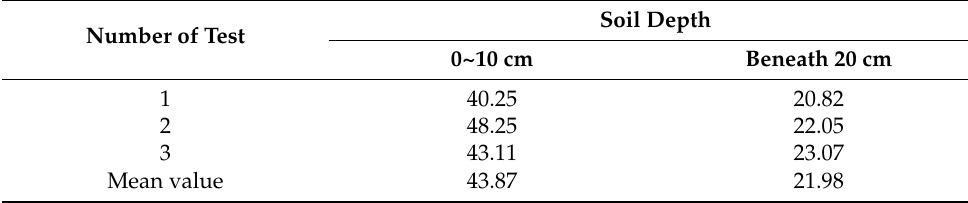
Table 3. Soil moisture content (%).